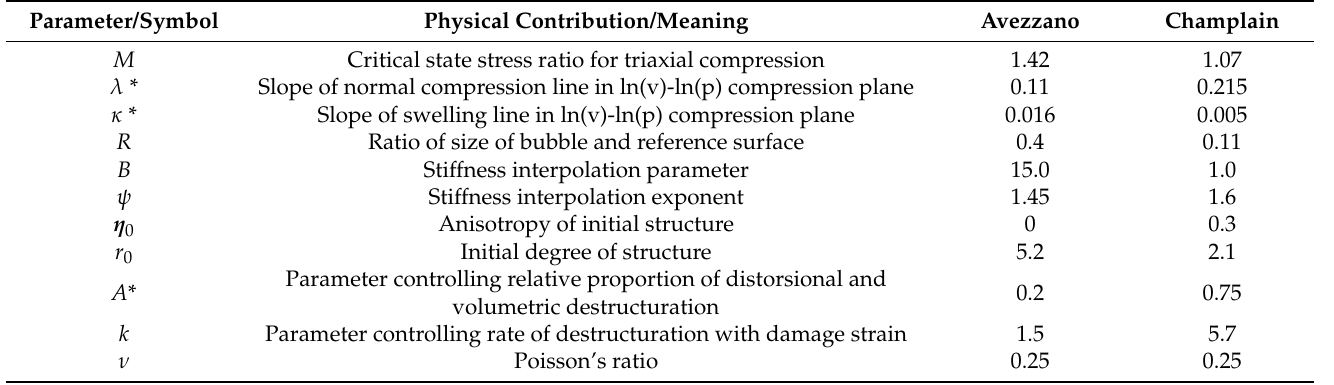
Table 1. RMW parameters for Avezzano and Champlain